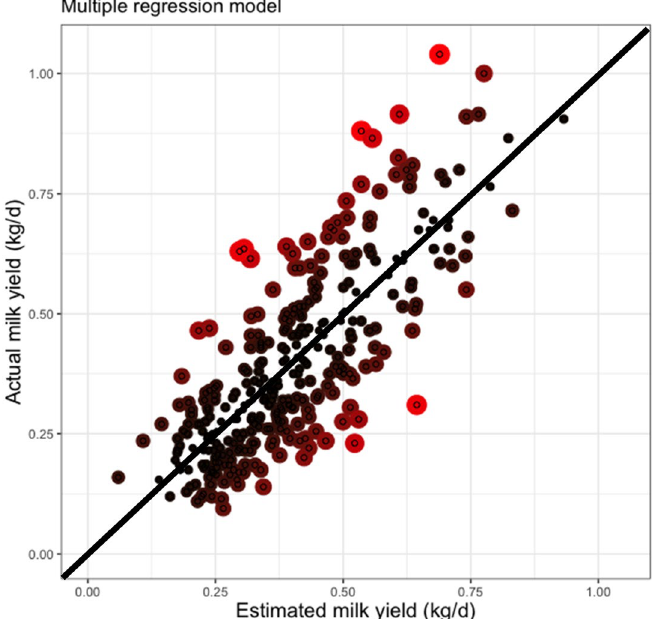
Figure 3. Residual analysis of multiple regression model to estimate milk yield using morphometric measures of udder from Pelibuey sheep. The color and size of circles represents the magnitude of residuals. Black and red color means a lower and higher residual values,